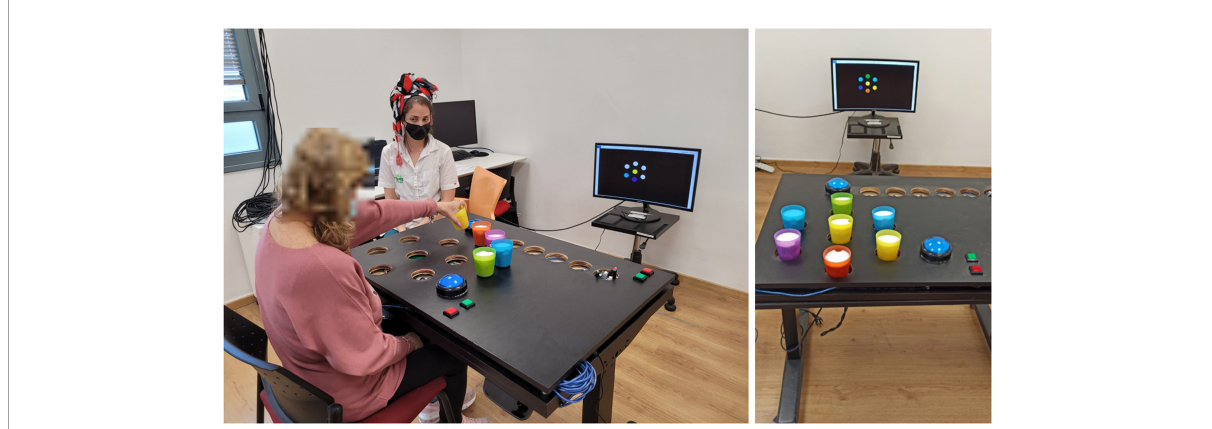
FIGURE1 The experimental setup. Left: The participant was seated in front of a height-adjustable table, behind which was a 27-inch computer screen, on which instructions and feedback were presented. The clinician sat in the same room, next to a second computer, used to monitor the experimental progression and input information about movement compensations that the participant performed. In each of 12 trials, a set of colored circles was displayed on the computer screen, arranged in a circle around a central location, similar to a bullseye arrangement. The participant had to place a corresponding set of colored cups on the table according to the picture shown on the computer’s screen. Right: The Target Exercise Game with all seven cup locations occupied, arranged according to the on-screen